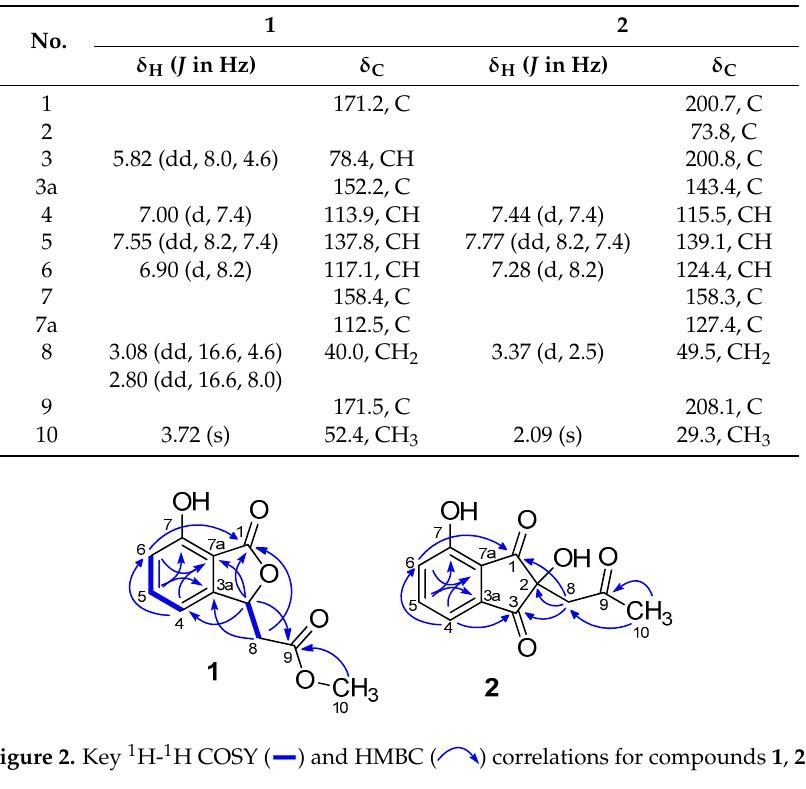
Table 1. 1 H-NMR (500 MHz) and 13 C-NMR (125 MHz) data for 1 and 2 in CD 3 OD.